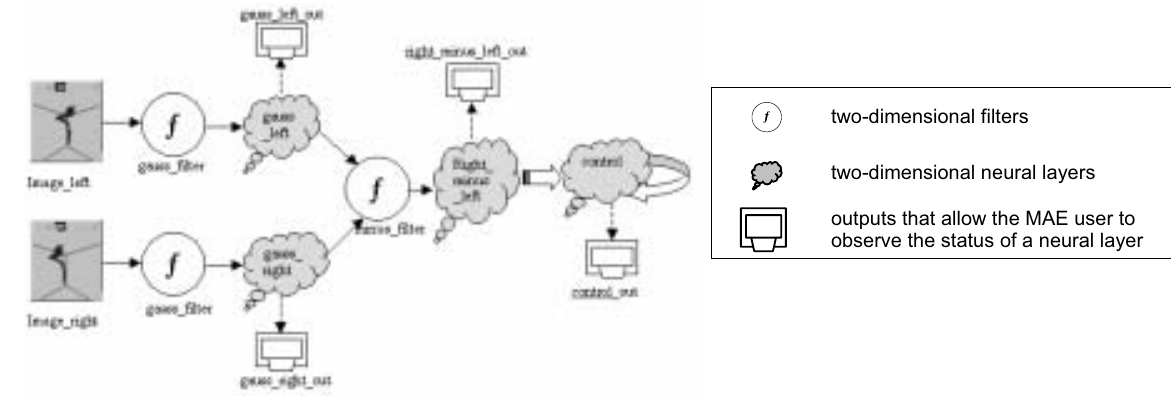
Figure 1 Simple neural architecture.